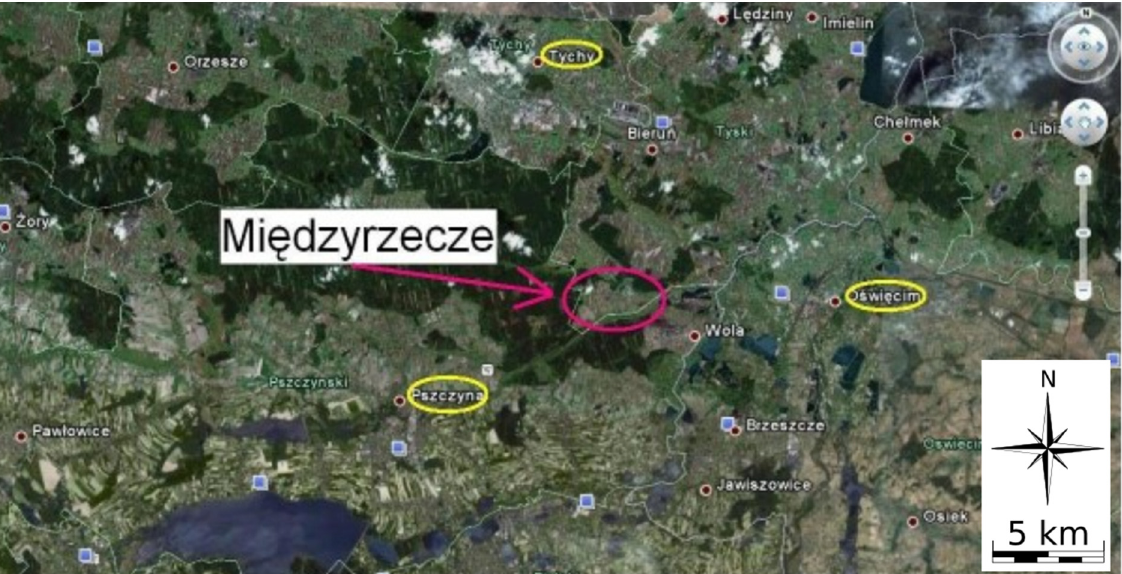
( a ) The red circle stands for the village of Mi ę dzyrzecze, and the yellow circles for the neighboring towns.